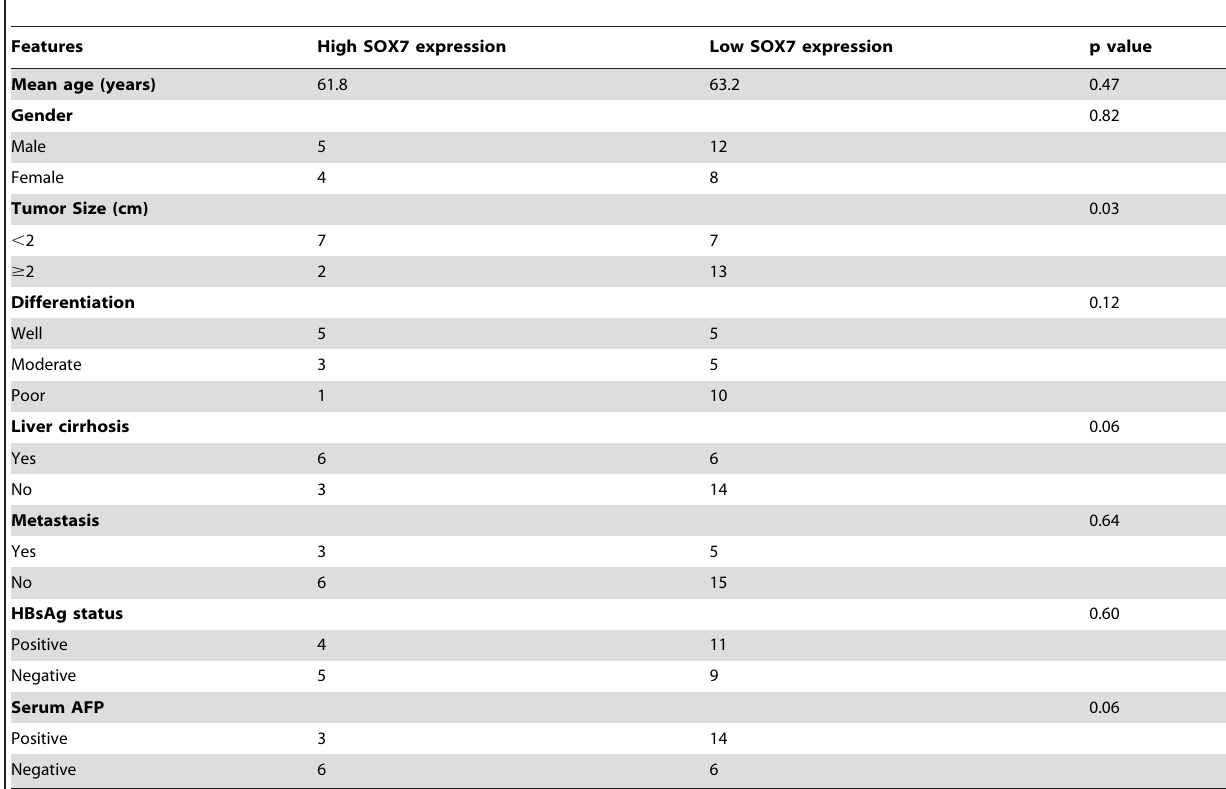
Table 1. Relationship between SOX7 expression and clinicopathologic features of patients with hepatocellular